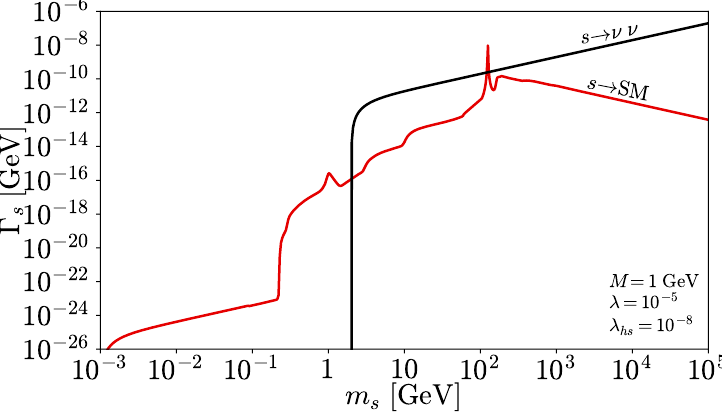
Figure 12 . The total SM decay width of s and (cid:0)( s ! (cid:23)(cid:23) ) for (cid:21) = 10 (cid:0) 5 , (cid:21) hs = 10 (cid:0) 8 and M = 1